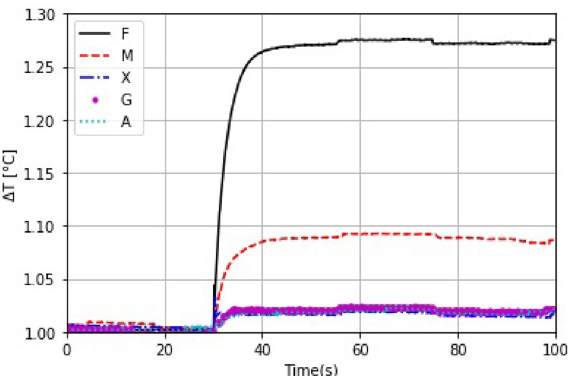
◦ C ) recorded for the samples during 100 s